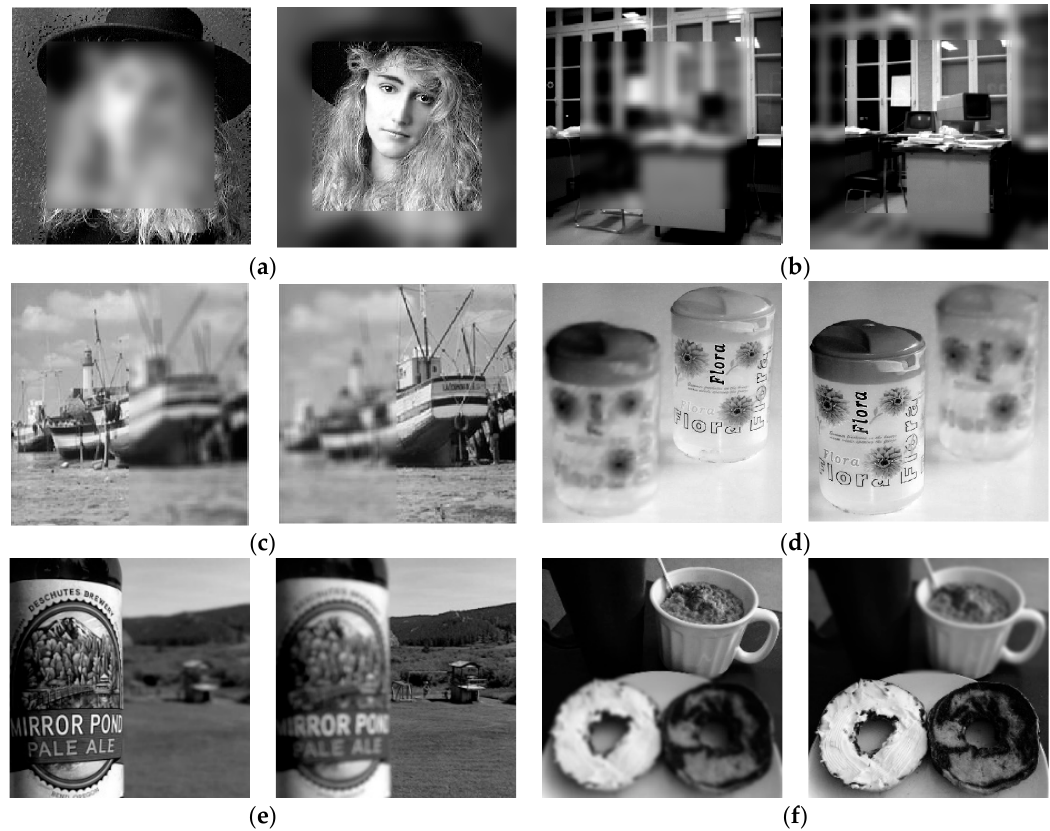
Figure 4. Experimental image sets ( a ) source image set named “head”, ( b ) source image set named “office”, ( c ) source image set named “boat”, ( d ) source image set named “medicine bottle”, ( e ) source image set named “wine bottle”, ( f ) source image set named “bread”.